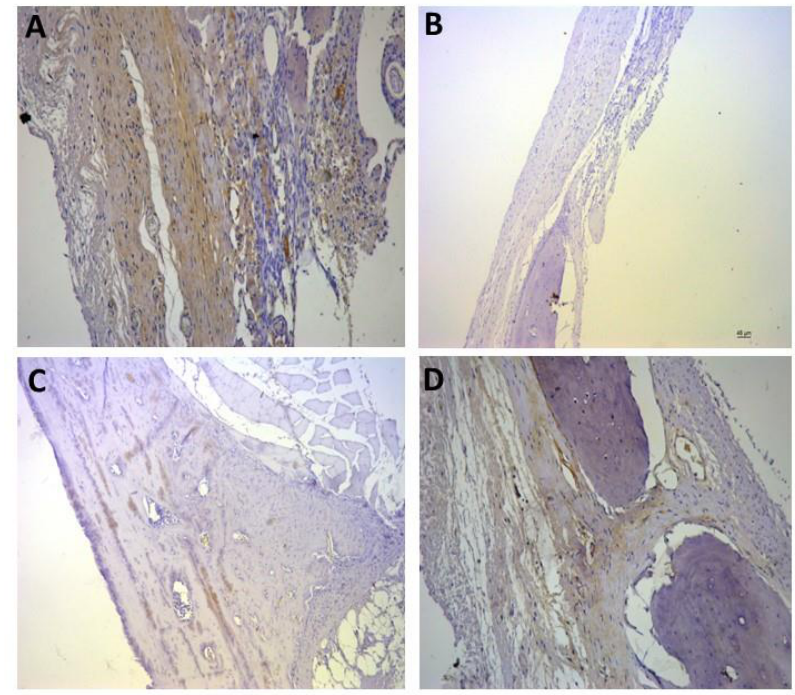
Figure 11. Representative immunohistochemistry images for TRAP staining. ( A ) control group; ( B ) negative control; ( C ) group 2 with marking considered (+); ( D ) group 4 with marking considered (++); the most observed staining pattern among the groups analyzed. Harris ’ hematoxylin counterstained. Scale bar: 46 µm.